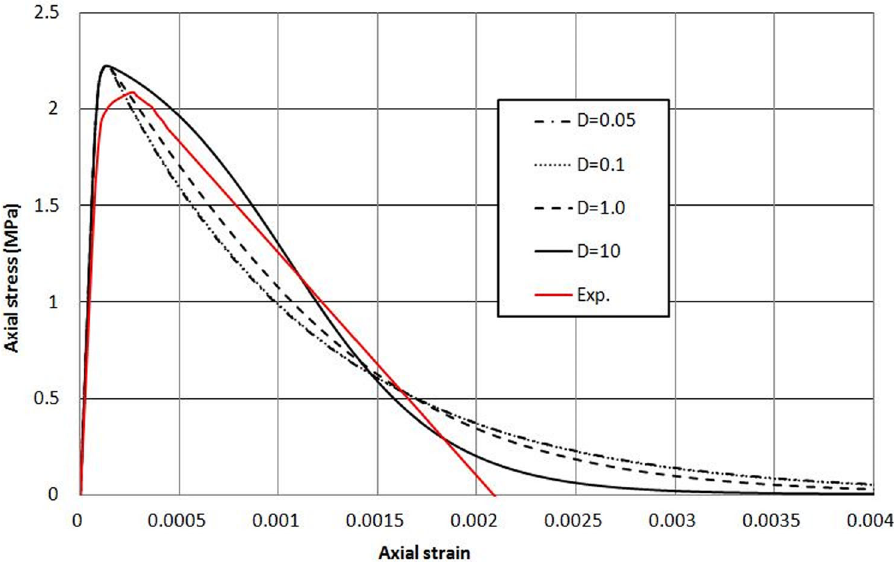
Fig. 7 Comparison of uniaxial tension behavior of CSCM model and experimental data taken from Mousavi et al.